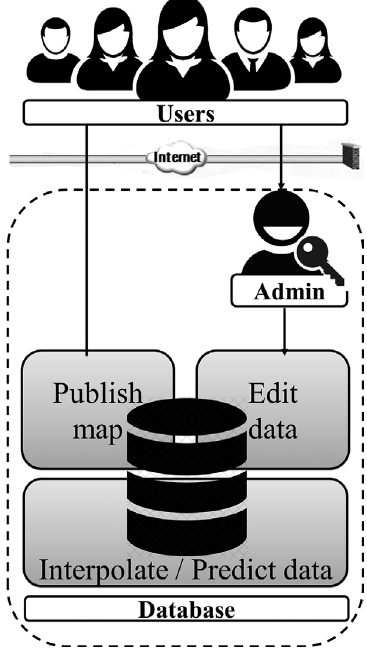
Figure 7. GIS framework of real-time pollution mapping and management